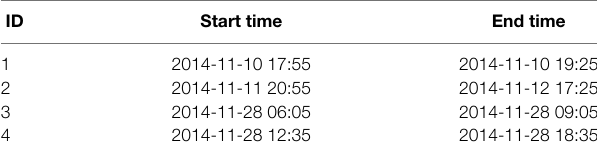
TABLE 1 | AMDA derived dynamic pressure peaks (>0.1 nPa) as modelled by Tao et al. (2005). Times are given in the format YYYY-MM-DD